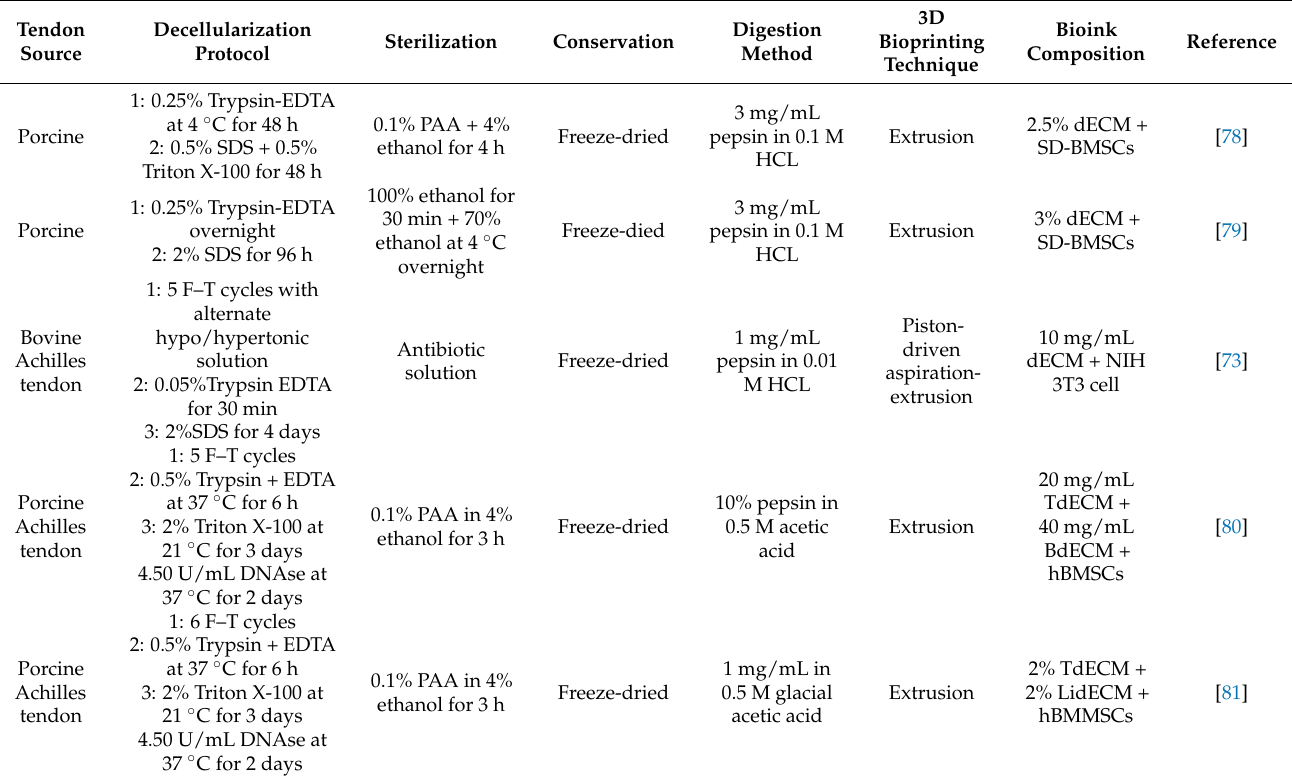
Table 4. Optimized protocols for tendon dECM bioinks for 3D